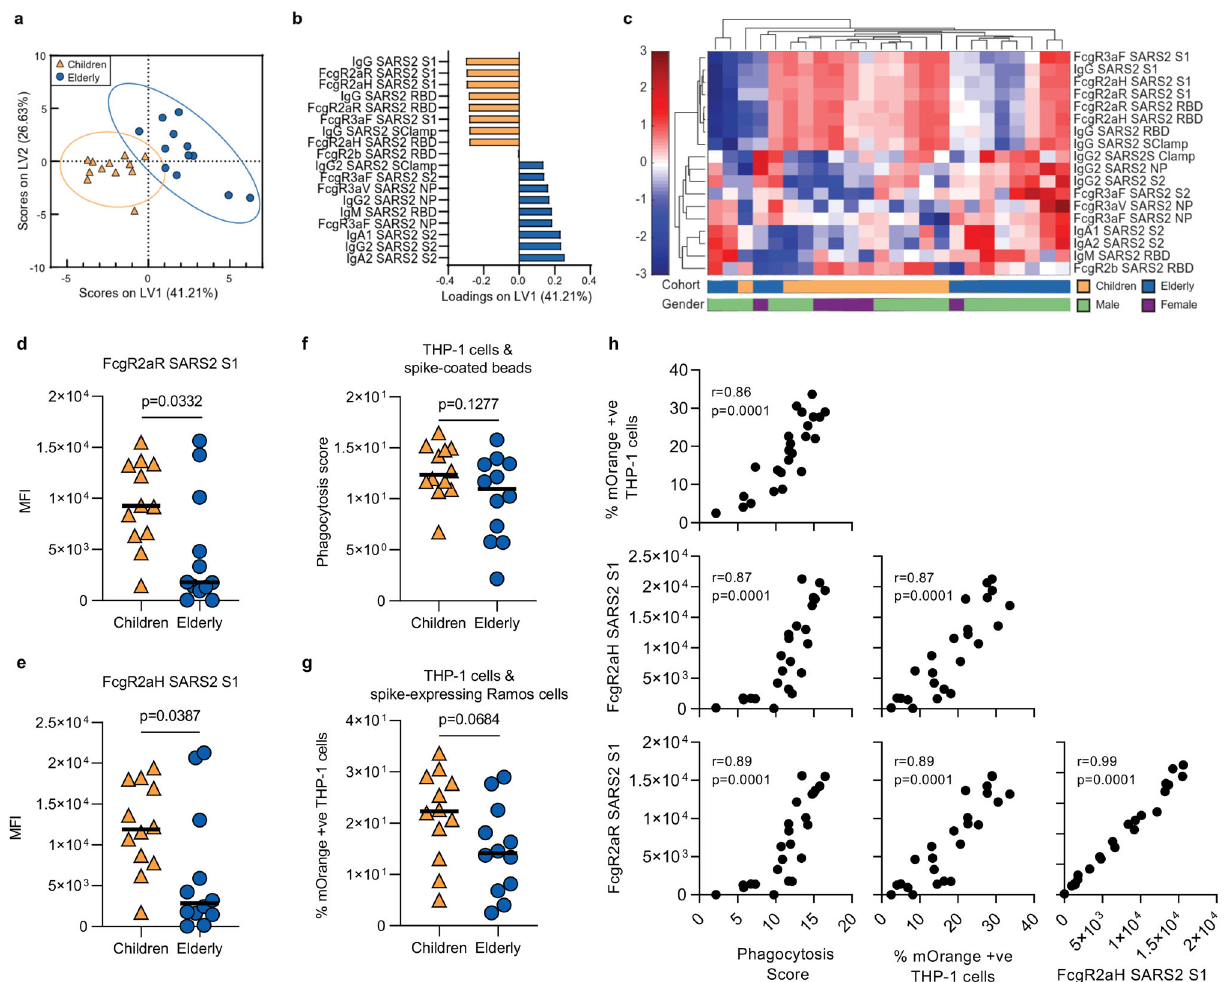
Fig. 6 COVID-19 Ab responses in COVID-19-positive children and elderly. PLSDA scores ( a ) and loadings ( b ) plots for the children ( n = 12) (orange) and elderly ( n = 12) (dark blue) with an Elastic-Net-selected 18-feature signature (100.00% calibration accuracy, 91.37% cross-validation accuracy). Hierarchical clustering was performed using the 18-feature signature for the children and elderly cohorts ( c ). S1-speci fi c antibody engagement of Fc γ RIIaR ( d ) and Fc γ RIIaR ( e ) were amongst the strongest features in the PLSDA loadings plot ( b ) and are signi fi cantly elevated in children (Supplementary Data 5 describes all comparisons between children and elderly). THP-1 monocyte cell line antibody-mediated uptake of spike-coated bead assay ( f ) and spike- expressing target cell assay ( g ). Statistical signi fi cance was calculated using the two-tailed Mann-Whitney U test and exact p -values were reported. S1- speci fi c antibody engagement of Fc γ RIIaR, Fc γ RIIaR and the two THP-1 SARS-CoV2 spike Fc effector assays highly correlate with each other, as measured by two-tailed Spearman correlation ( h ). Multiplex assays were repeated